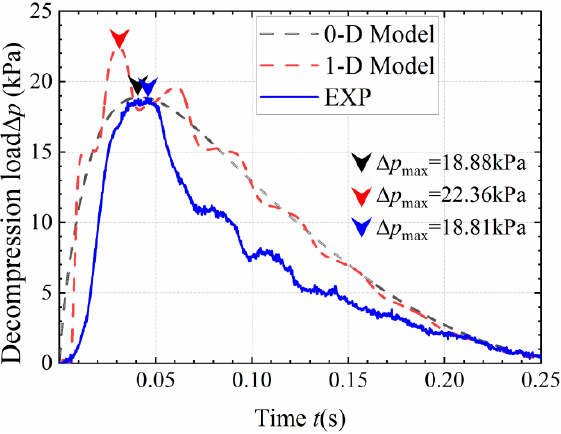
Figure 9. Curves of decompression load (experimental